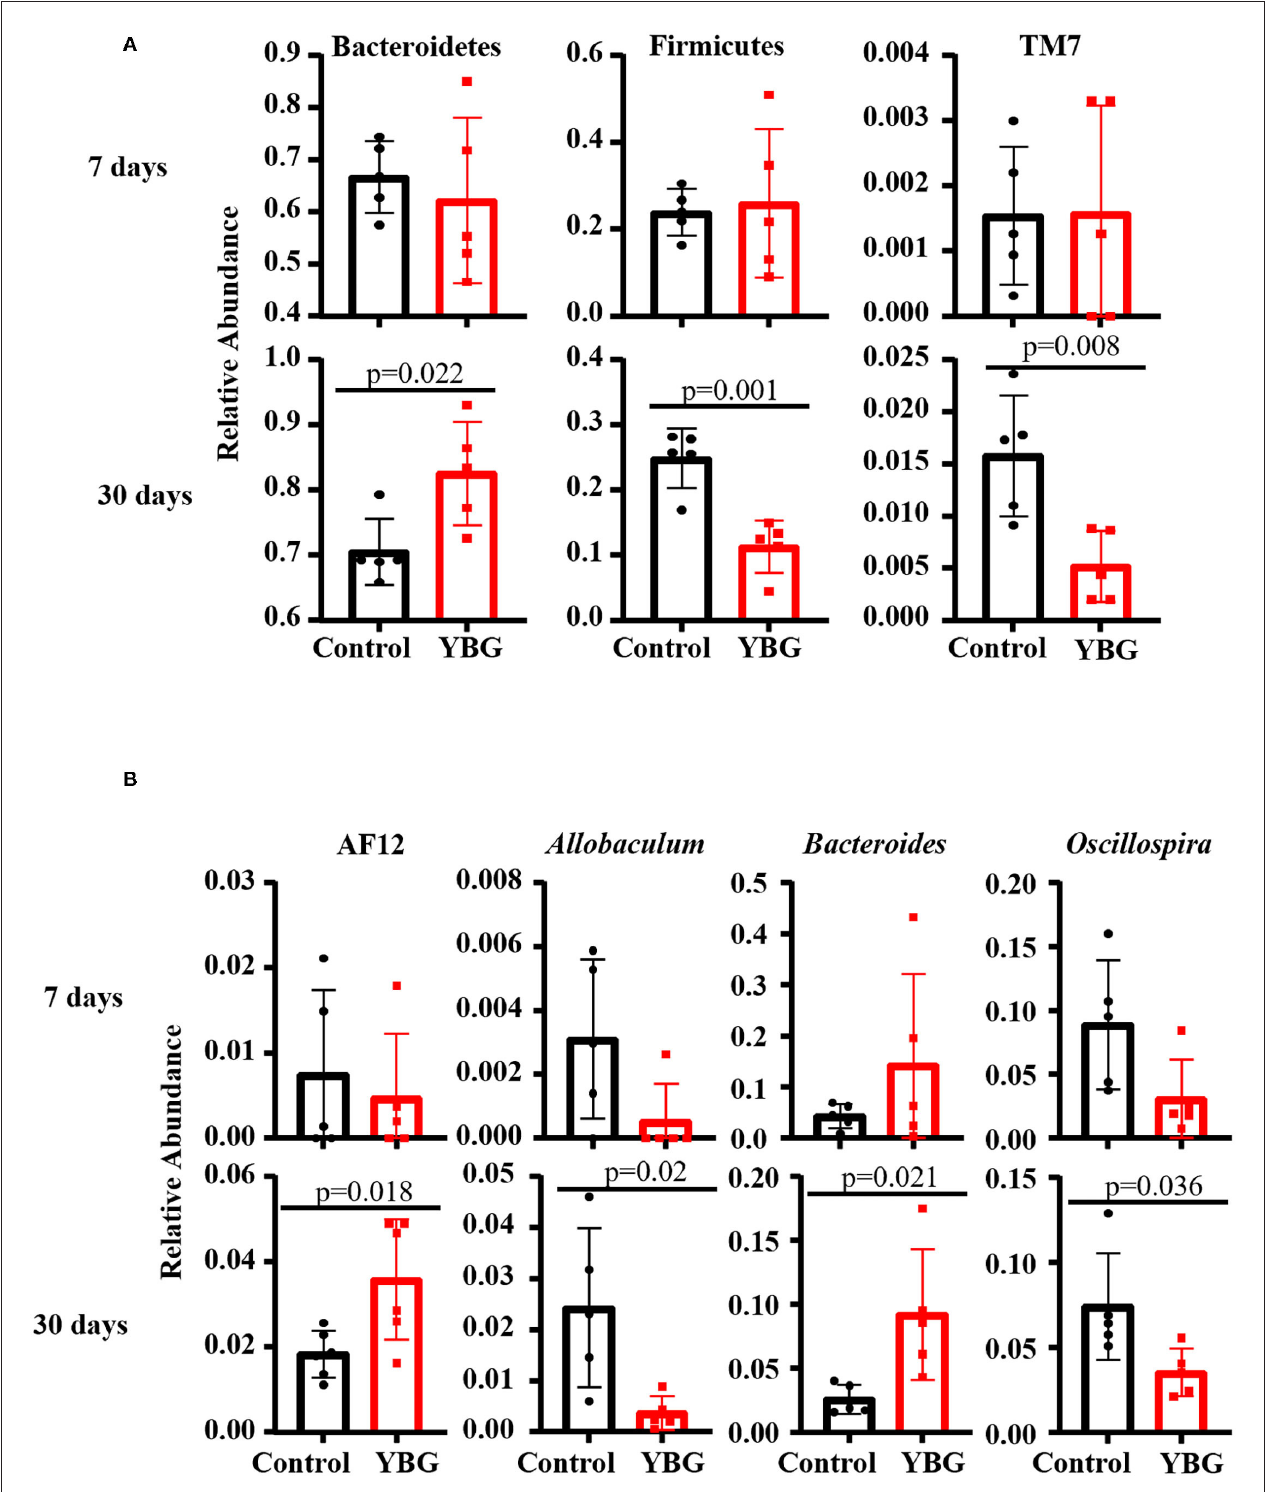
FIGURE 2 | Differences in the fecal bacterial composition between control and YBG-treated NOD mice. Fecal samples of mice collected after 7 (5 mice/group) and 30 days (5 mice/group) of YBG treatment were subjected to 16S rRNA gene sequencing as described and analyzed employing Illumina Metagenomics application as described for Figure 1 . The relative abundances of major microbial communities at phylum (A) and genus (B) levels with statistically significant differences are shown. P -values by unpaired t -test. Additional analyses are presented in Supplemental Figures 2 , 3 .